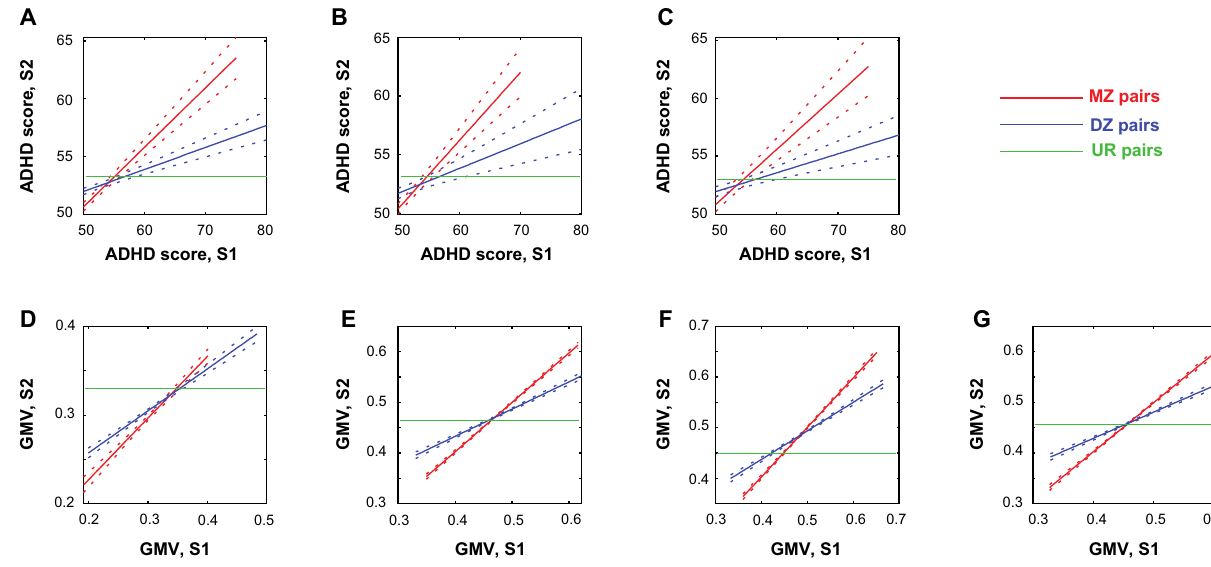
Figure 3. Pearson’s correlations between monozygotic (MZ) pairs, between dizygotic/siblings (DZ) pairs and between unrelated (UR) pairs in ADHD score for ( A ) all, ( B ) girls, and ( C ) boys; and in GMV correlates in ( D ) positive and ( E ) negative correlations with ADHD scores for all, as well as ( F ) “girl-specific” and ( G ) “boy- specific” GMV correlates for all. S1 and S2: subject 1 and 2 of the pair. The r and p values of the correlations and the results of slope tests are shown in Supplementary Tables S6 and S7, respectively.